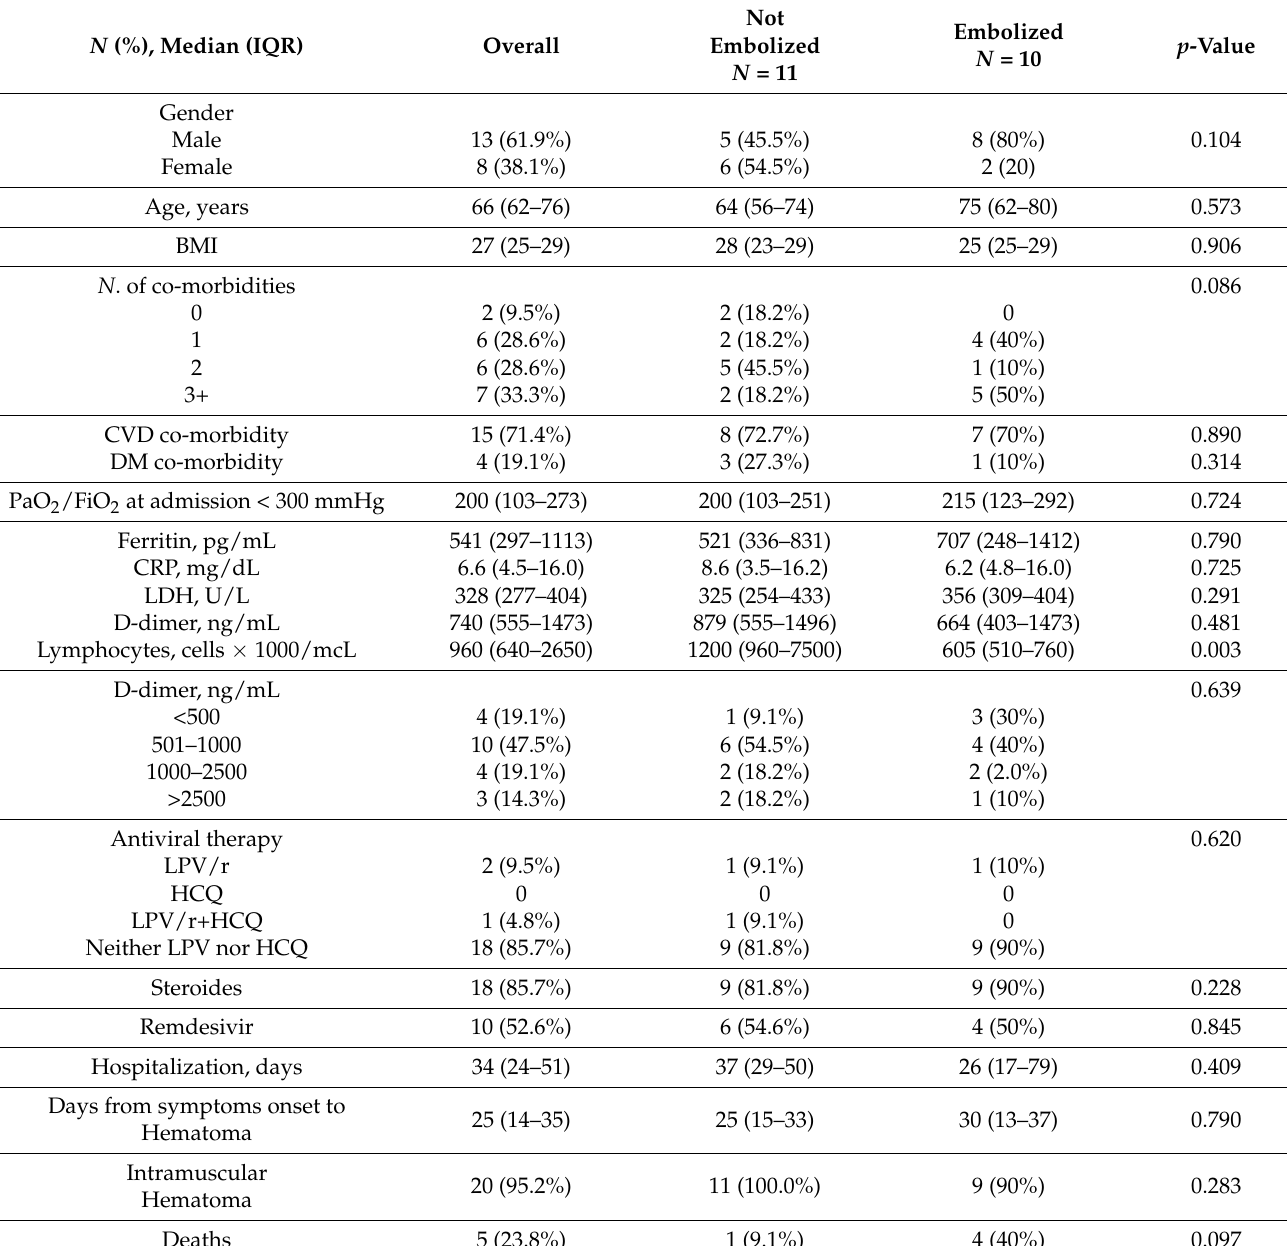
Table 1. Sociodemographic, laboratory tests, and clinical